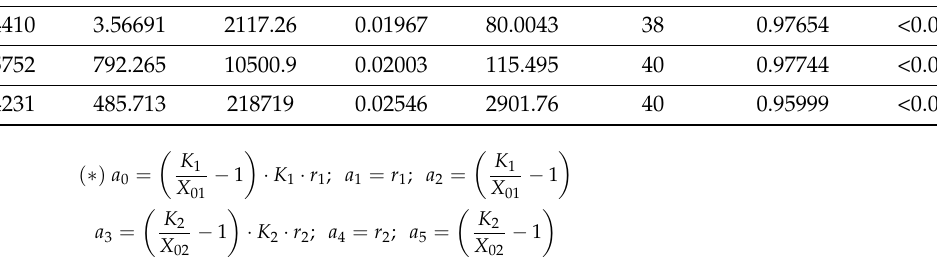
Table 1. Values of fitting parameters of model (3) for the all stages of pest population of Rhynchophorus. Fitting Parameters (*) Stage